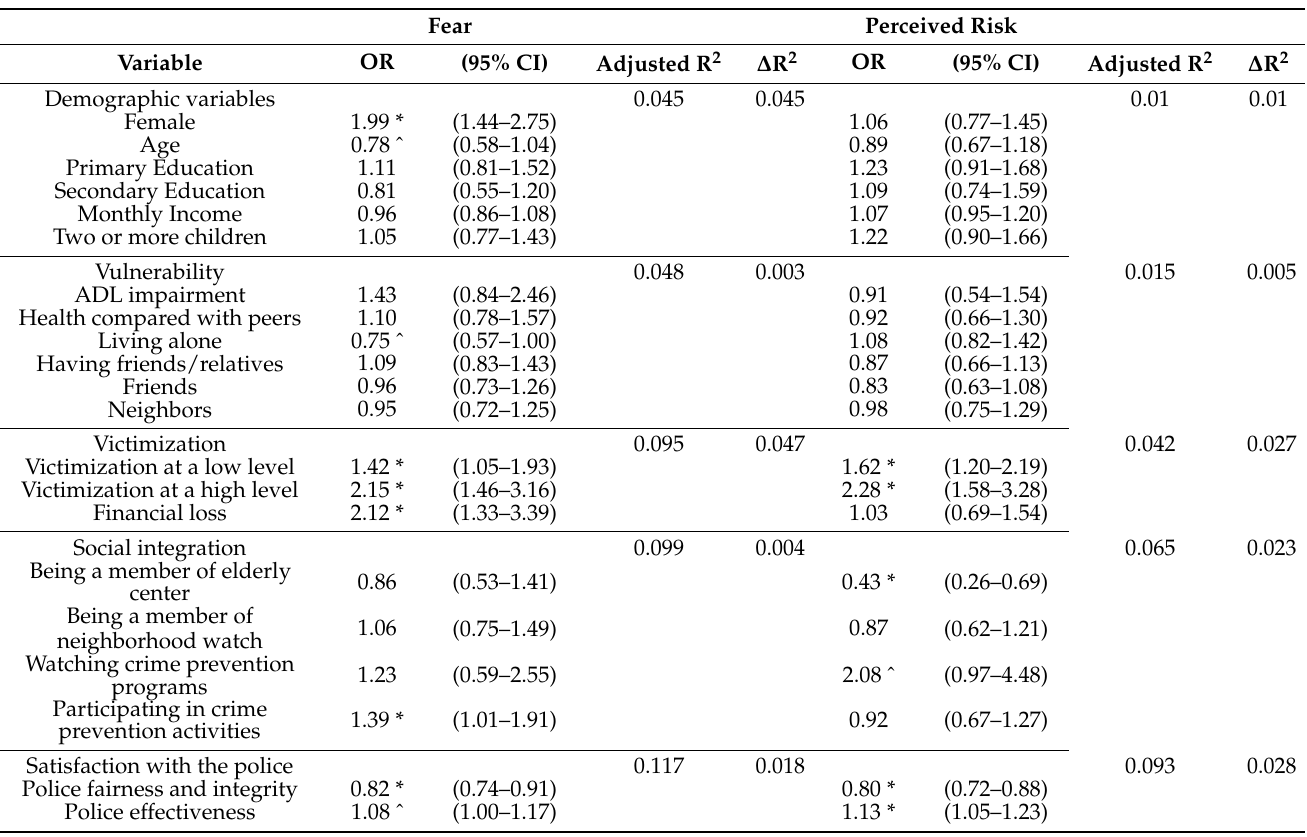
Table 3. Logistic regression predicting fear and perceived risk of fraud by strangers ( N =